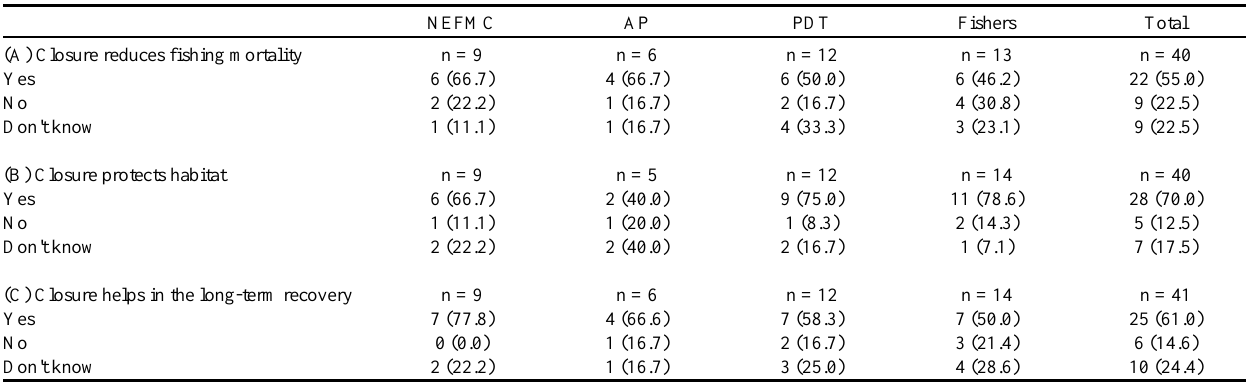
Table 7 . Opinion about the effectiveness of the Western Gulf of Maine Area Closure (WGoMAC) for each of the surveyed groups: (A) Does the closure reduce fishing mortality? (B) Does the closure protect habitat that groundfish require? and (C) Does the closure help in the long-term recovery of groundfish stocks? Values in parentheses are